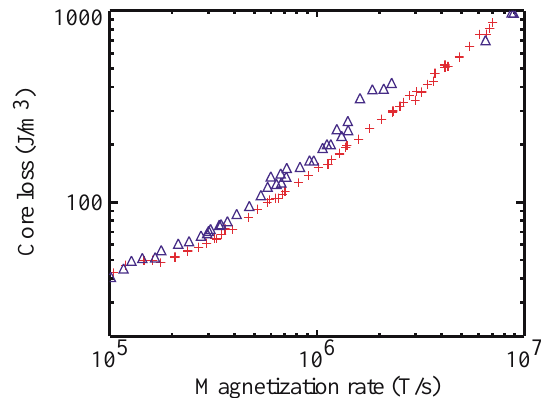
FIG. 17. (Color) Core loss versus magnetization rate for four FINEMET FT-1H nanocrystalline cores, manufactured by Hi- tachi. The data are for the listed flux swings: ( (cid:1) , green) 982-4 at 2.00 T; ( (cid:3) , blue) 982-3 at 2.05 T; ( 1 , red) 982-2 at 2.05 T; and ( 3 , black) 982-1 at 2.10 T.